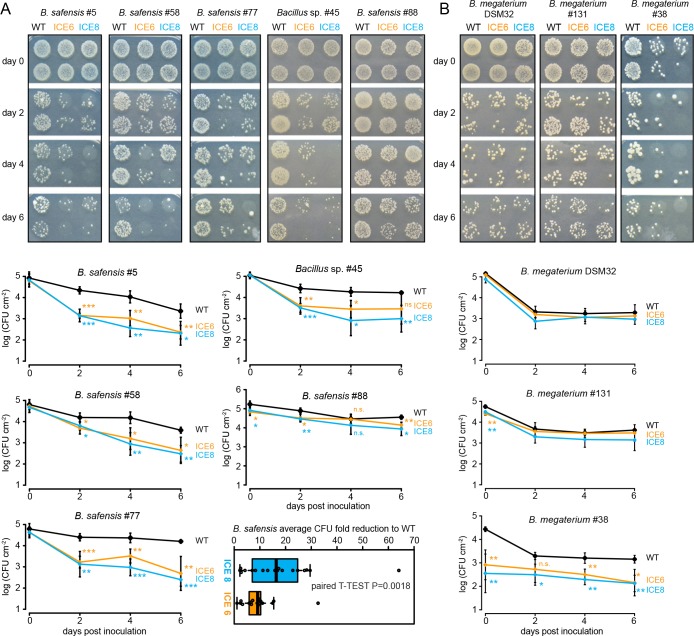
In planta activity of N. attenuata ICE lines against Bacillus isolates. Different endophytic isolates were injected by pressure infiltration into fully expanded rosette-stage leaves and re-isolated at 0, 2, 4 and 6 dpi. The pictures show two technical replicates per genotype and time point. The mean colony forming units (CFU) were plotted as log CFU cm−2 leaf area (±SD, n = 4 plants). Asterisks indicate statistically significant differences between WT and transgenic plants (t-test; *p≤0.05; **p≤0.01; ***p≤0.001; n.s. = not significant). (A) For the isolates of the Bacillus pumilus/safensis clade #5, #58, #77, #45 and #88 the consolidated results indicated stronger CFU fold reductions for line ICE 8 compared to line ICE 6. Dots represent average values at 2–6 dpi with the medians as the centered lines limited by 25th and 75th percentiles and 1.5 times extended whiskers after Tukey (n = 18 sample points; paired t-test; p<0.002). (B) Infiltration of the Bacillus megaterium type strain DSM32, isolates #131 and #38.